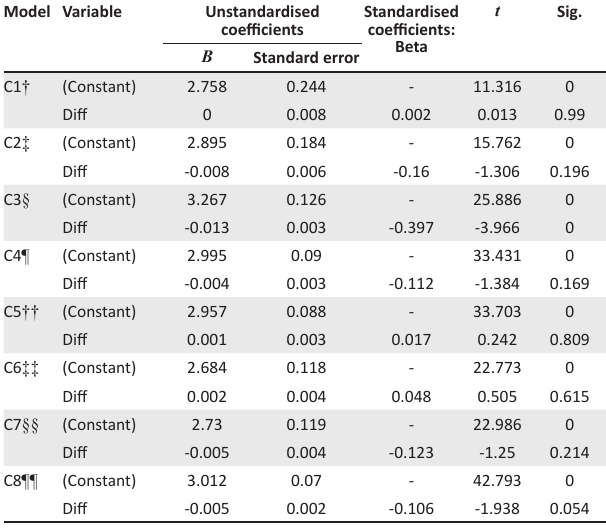
TABLE 5: Conditional regression result of creative talents (gender). Model Variable